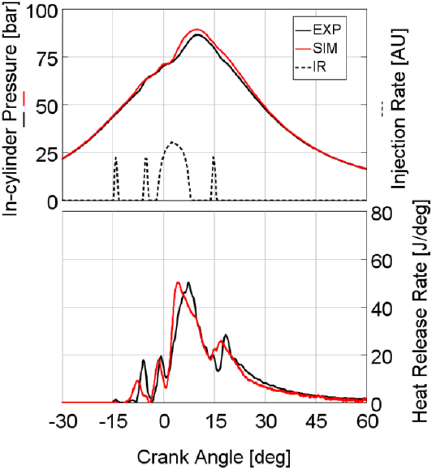
Figure 9. Top: simulated (red) vs. experimental (black) in-cylinder pressure, injection rate (dashed black). Bottom: simulated (red) vs. experimental (black) Heat Release Rate. WP: 2000 rpm × 8.0 bar BMEP.